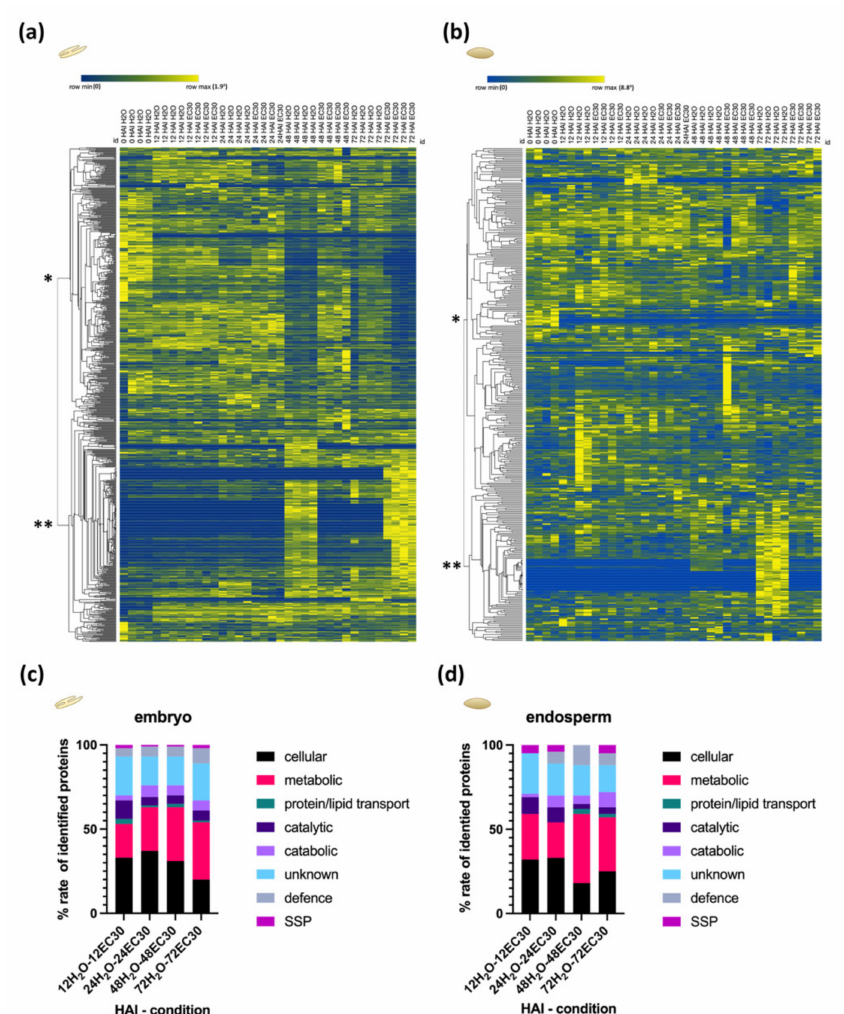
Figure 4. HCA of protein abundances ((labelled-free quantification (LFQ) intensities)) of the different stages during germination and biological classification of identified proteins of the ( a ) embryo and ( b ) the endosperm. * and ** represent the two clusters where the protein abundance is higher and lower, respectively. Blue = low abundance, yellow = high abundance. ( c , d ) The biological classification of all significantly differentially expressed proteins during germination in the ( c ) embryo and ( d )